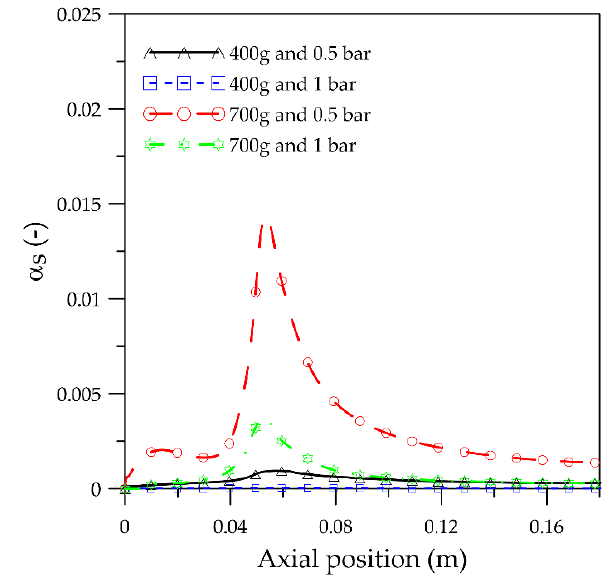
Figure 7. Axial distribution of the time-averaged solid volume fraction at the center of the fluidized bed, from the fluidized bed bottom (axial position equal to zero) to the transporting region. As expected from Figure 6, very low solid volume fractions were observed over the axial position throughout the fluidized bed, with maximum values at the griding region that decreases towards the transport region (Figure 7).